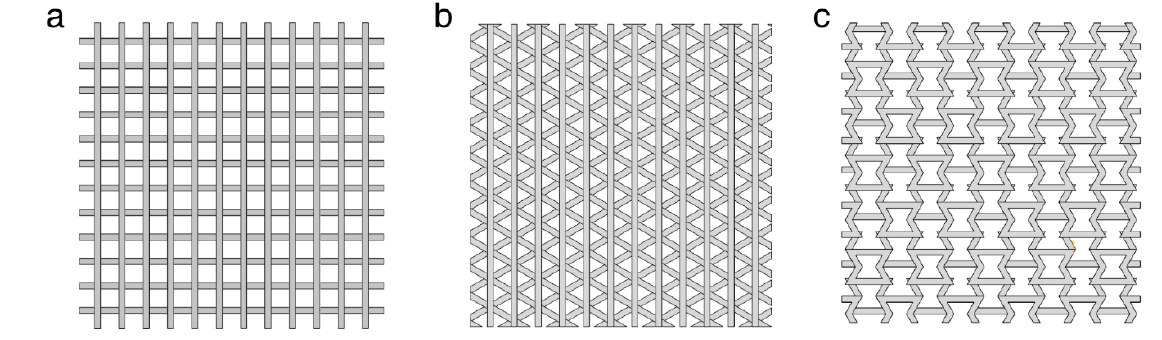
Figure 2. Three different fill structures ( a – c ).